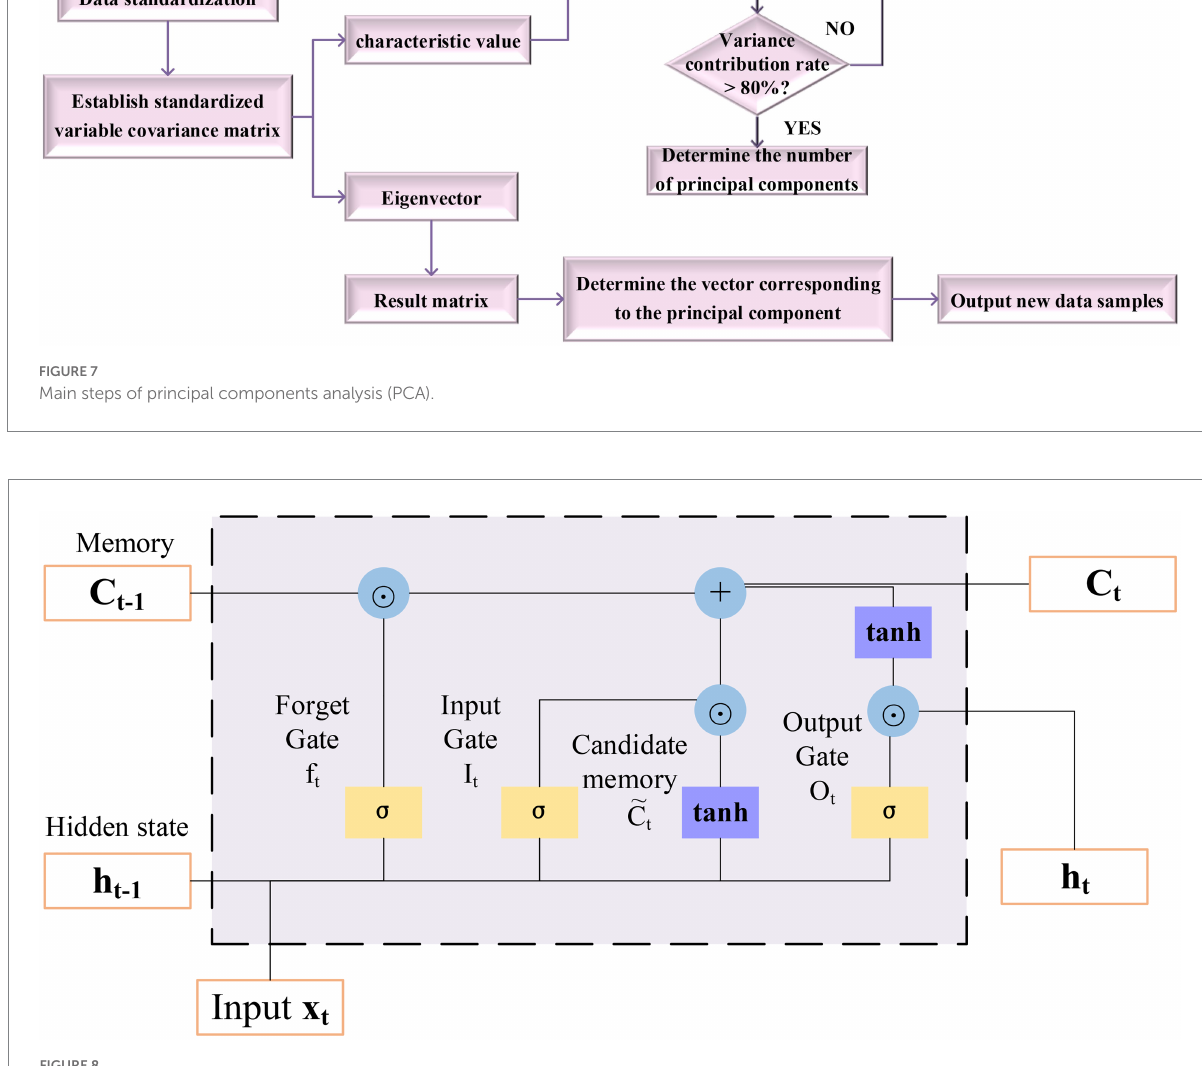
FIGURE 8 Structure of long short-term memory (LSTM).